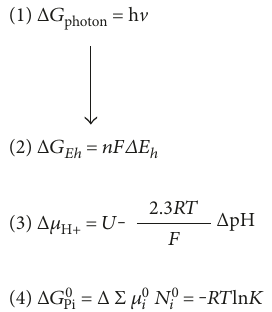
Scheme 1: Steps of the free energy conversion in the reaction scheme of photosynthesis. Energy of photon (1) is converted to redox potential (2) of the cofactors within the RC and between the protein components of the electron transport chain. Redox free energy is coupled to proton motive force (3) across the membrane, which is coupled to phosphorylation potential (4) indicated by the solid